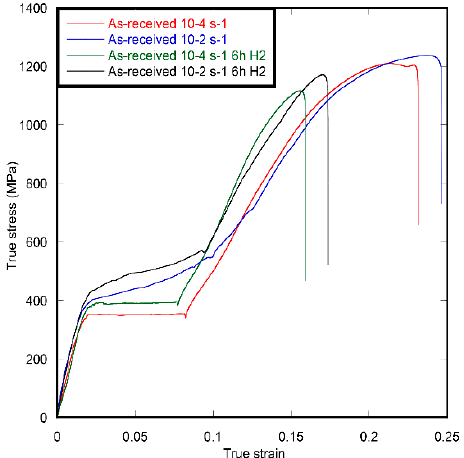
Figure 2. True tensile curve of as-received specimens, charged for 6 h with current density of 10 A/m 2 and aged at room temperature at strain rates of 10 − 4 s − 1 and 10 − 2 s − 1 .